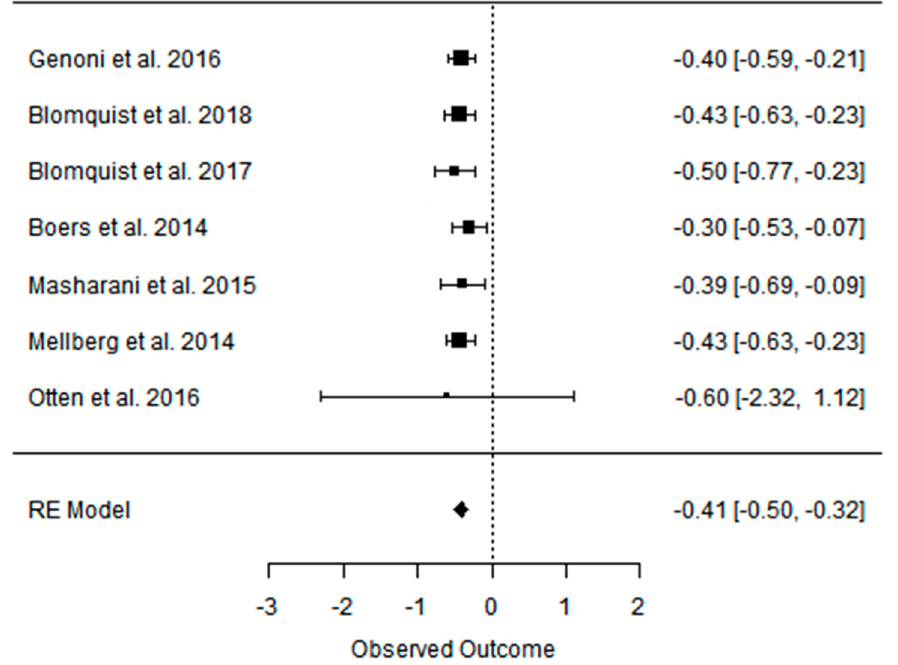
Figure A24. Forest plot of the effect of PD on LDL-C in the short term (weighted mean difference).